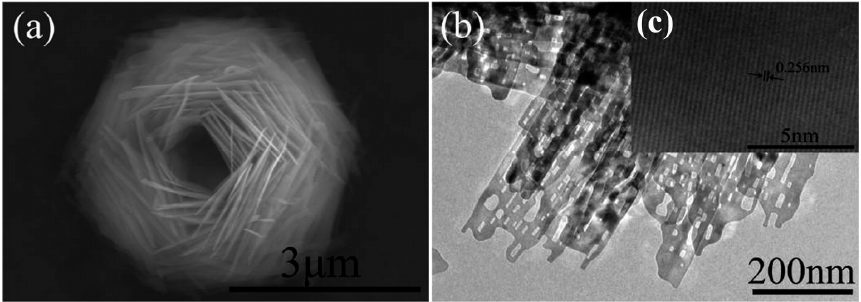
Figure 9. ( a ) SEM, ( b ) TEM and ( c ) HR-TEM images of nest-like 3D ZnO porous structures (Reproduced with permission from [93], Copyright 2014, American Chemical Society).